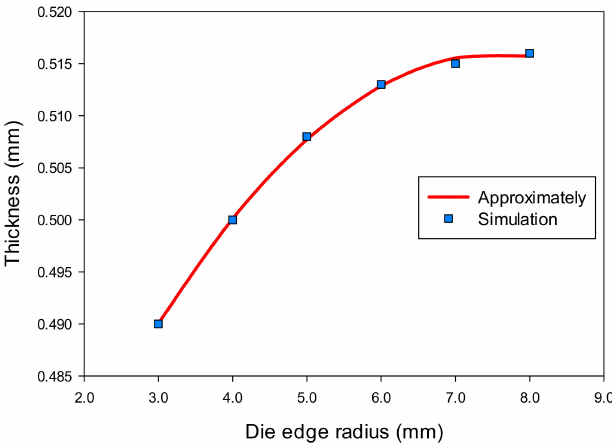
Figure 11. The effect of die edge radius on